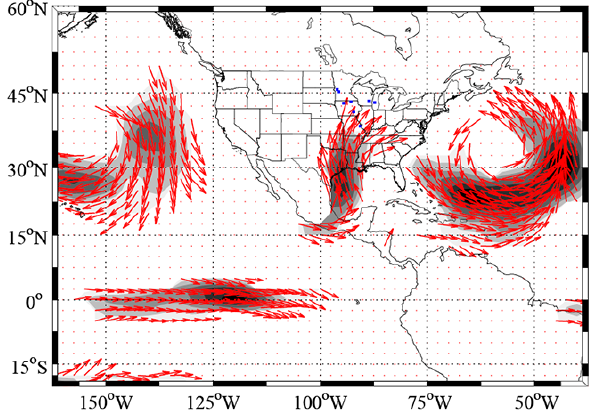
Figure 1. Vertically integrated moisture flux averaged over the dates of the 10 largest floods in the Ohio River basin in North America from 1948 to 2005. The flux is computed daily over 1000–850mb, using the NOAA-NCEP reanalysis data set. The arrows show the wind direction, and the shading shows the intensity of the moisture flux. Only pixels whose moisture flux magnitude is in the top 5% of the visible map are shown. Note that a large-scale meridional low- level flow into the region is active averaged across these 10